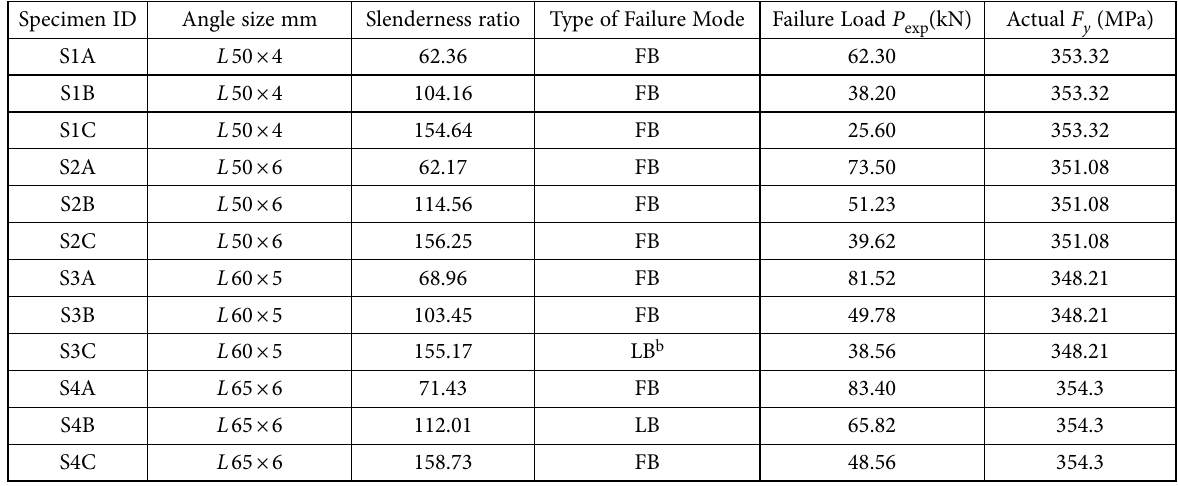
Table 7. Experimental test result for single bolted angle specimens